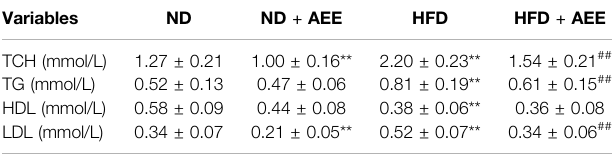
TABLE 3 | Effect of AEE on blood lipids in rats with hyperlipidemia.